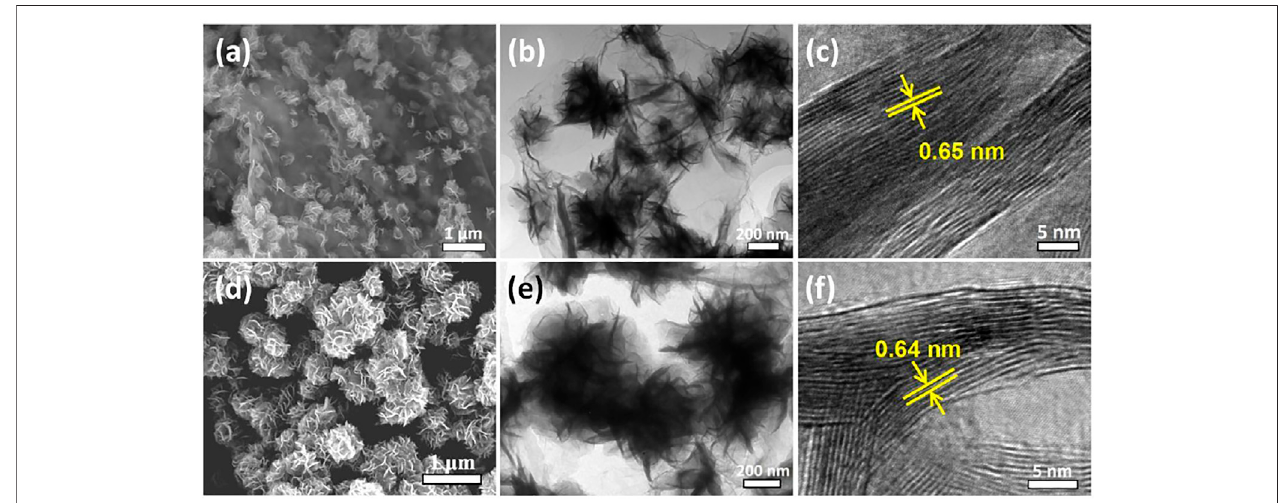
FIGURE 4 | SEM, TEM, and HRTEM images of the (A – C) rGO/MoS 2 -C and (D – F) pure MoS 2